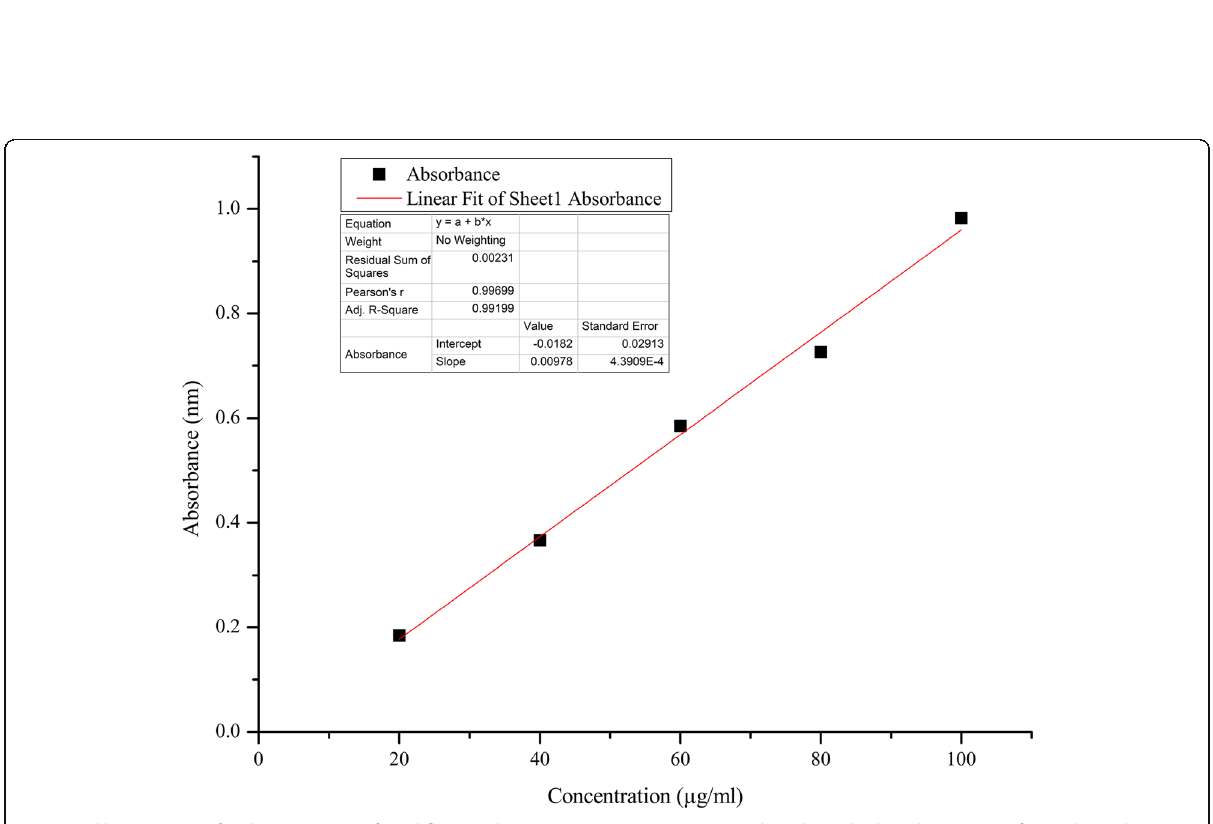
Fig. 2 Calibration curve for determination of total flavonoid content using quercetin, in methanolic and ethanolic extracts of C. zeylanica